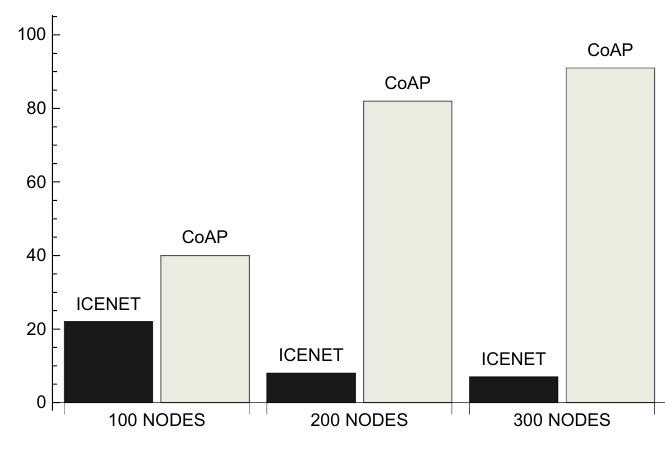
Figure 12. Average